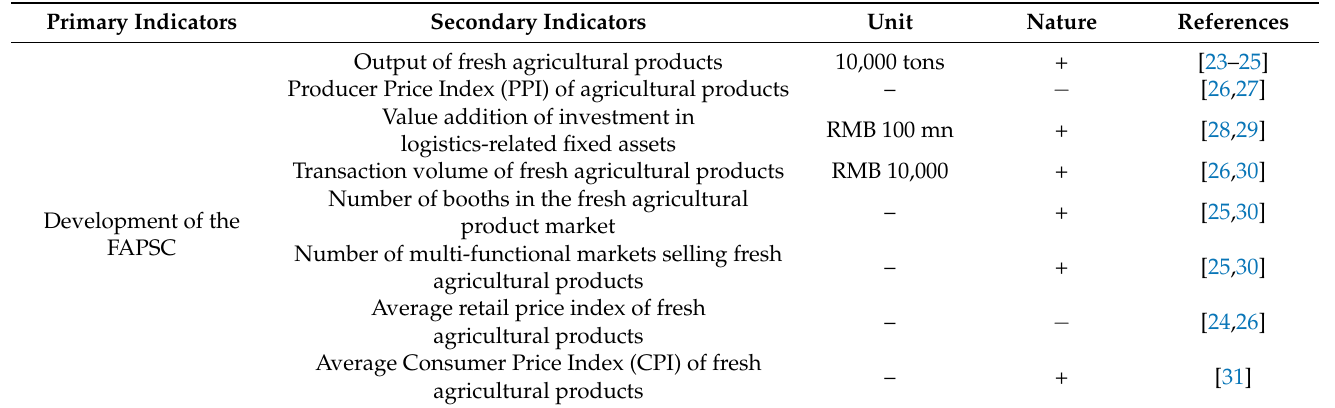
Table 1. Development assessment indicators for the